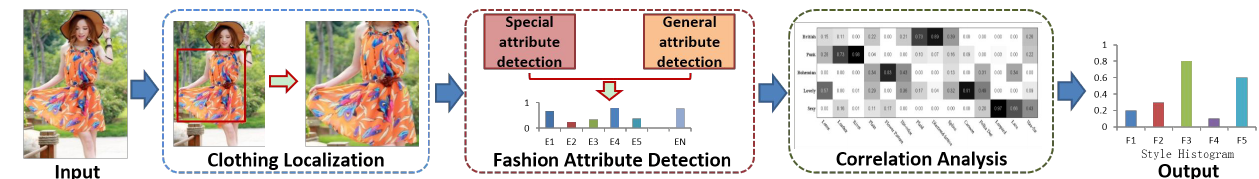
Figure 2: The whole framework for clothing style recognition